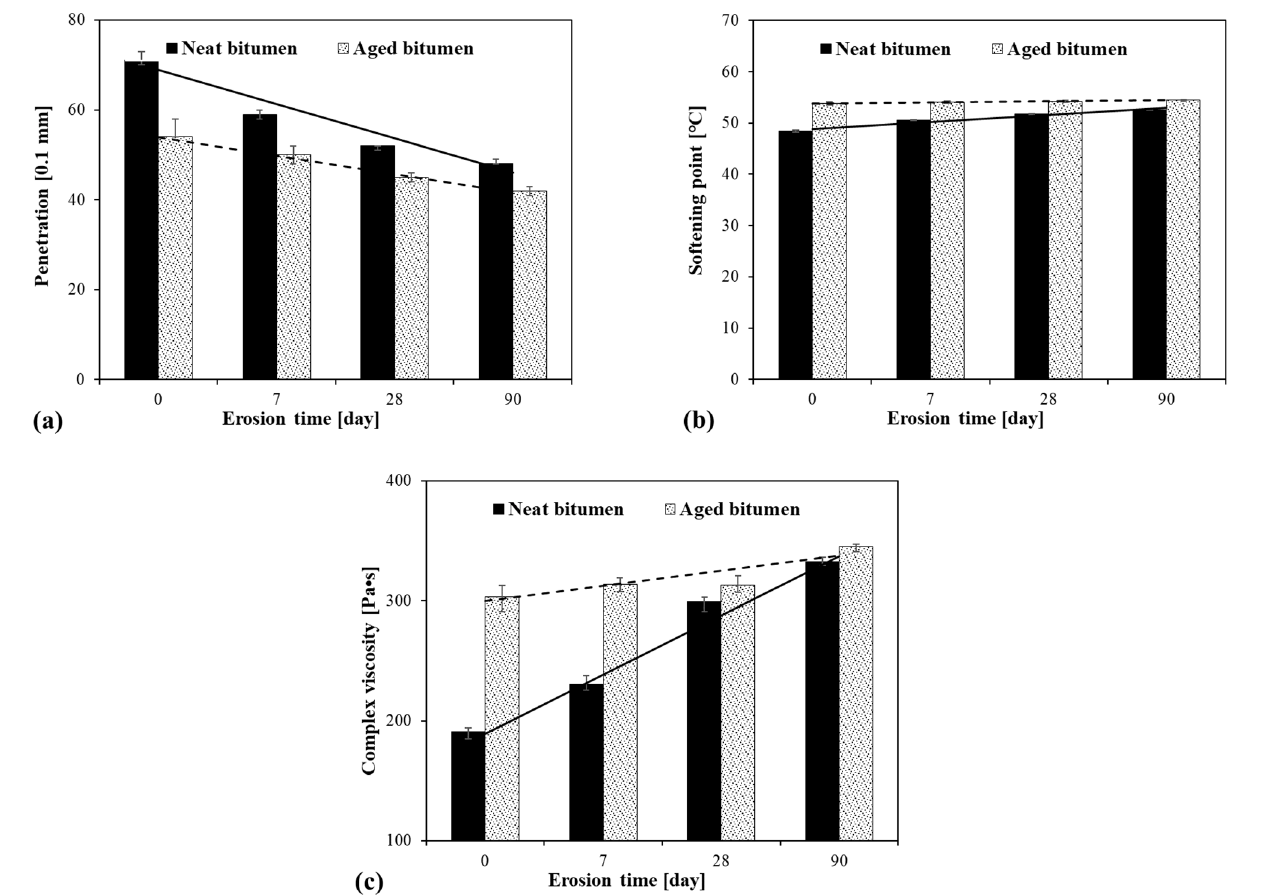
Figure 3. ( a ): Penetration; ( b ): softening point; ( c ): complex viscosity at 60 °C of the bitumen under different conditions versus erosion time.